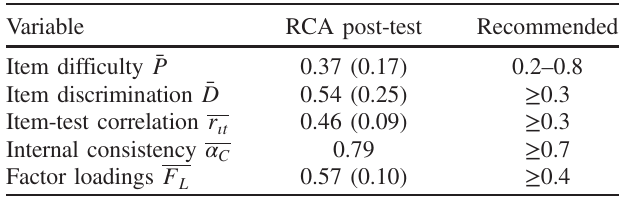
deviations (in parentheses) of item difficulty, item discrimination, item-test correlation, internal consistency and factor loadings, as well as the recommended ranges (Ref. [147]; factor loadings see Ref.